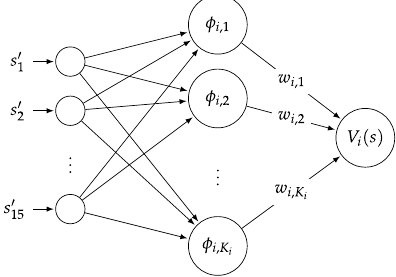
Figure 5. Structure of synthesized critic network. It accepts the normalized state vector s (cid:48) to approximate the value function for the i -th manipulating